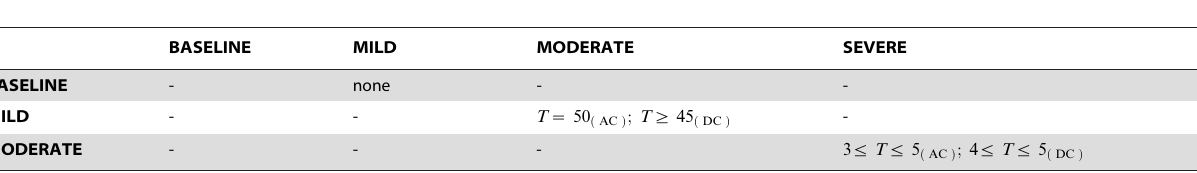
Table 6. Ranges of T in which a significant difference between two phases was found (Wilcoxon signed rank test, p , 0.05).